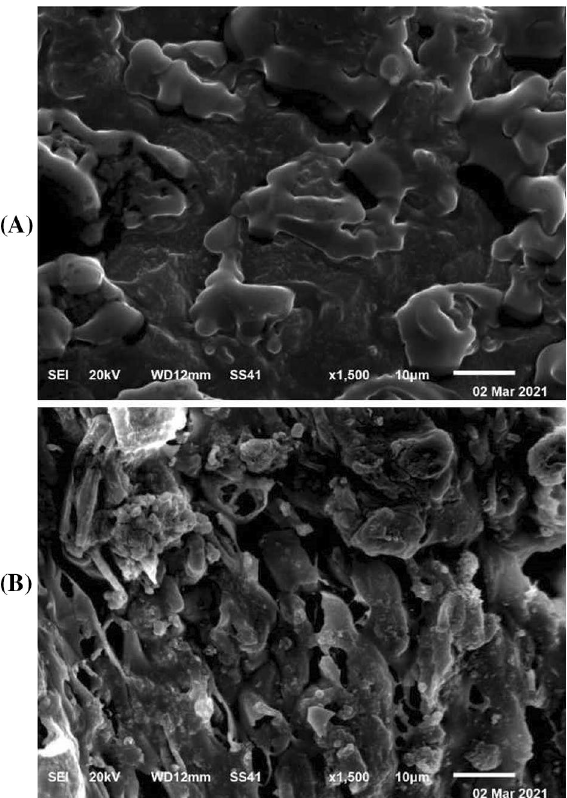
Figure 5. Scanning electron micrographs of Sargassum latifolium , showing the control of untreated algal biomass ( A ), and algal biomass treated with Cobalt(II) and MB ( B